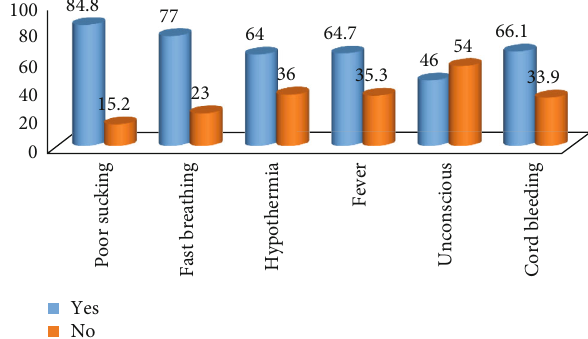
Figure 1: Identi fi ed newborn danger sign by mothers with babies of one-month-old after delivery in the community of Hossana town, southwest Ethiopia, 2018.